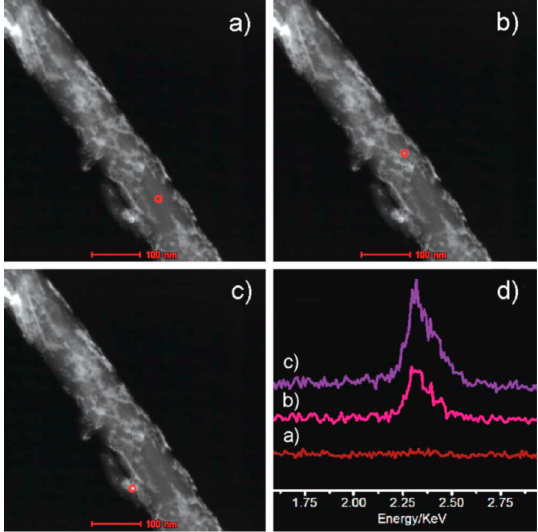
Figure 3. ( a – c ) High-angle annular dark-field (HAADF) images of three different sport, ( d ) Energy Dispersive X-ray Analysis (EDX) elemental spot-scanning profiles of the three representative spots of Mo 2 C/CNTs catalyst. Reproduced with permission from [40]. Copyright The Royal Society of Chemistry, 2011.